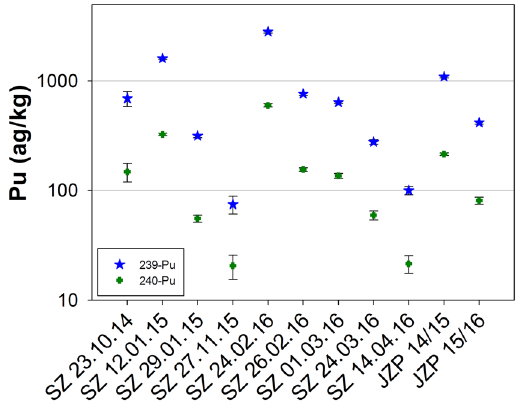
Figure 2. Concentrations of 239 Pu (blue star) and 240 Pu (green cross) in the snow samples. The error bars indicate expanded uncertainty (k = 2). SZ: freshly fallen snow Zugspitze, JZP: naturally accumulated